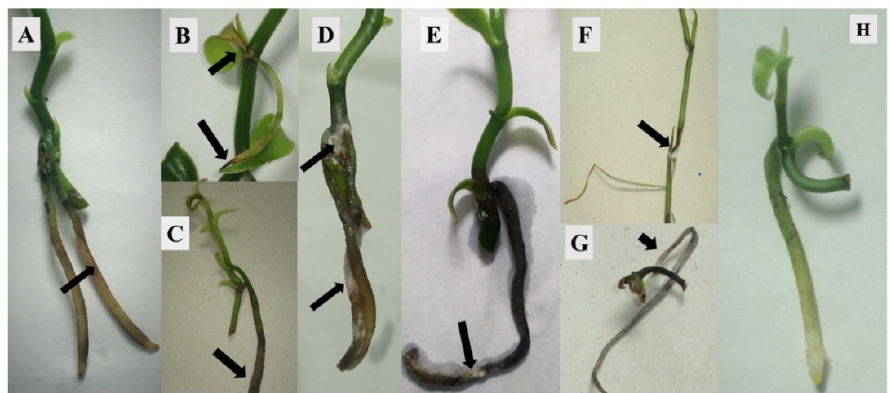
Figure 5. Development of symptoms caused by isolates of Fusarium oxysporum f. sp. vanillae in vanilla accessions. ( A ) Root browning in contact with the culture medium, V. planifolia NSF092; ( B ) aerial root with necrotic tip and wilted leaf, V. planifolia NSF021; ( C ) development of mycelium and wet root rot in contact with the culture medium of the F1 hybrid (NSF059 × NSF07); ( D ) wet root rot in contact with the culture medium, V. planifolia NSF092; ( E ) root dry rot in contact with the culture medium, V. planifolia NSF092; ( F ) stem strangulation, V. odorata (NSF023); ( G ) root strangulation in contact with the culture medium, V. planifolia NSF092; ( H ) control plant not inoculated with the pathogen. Symptoms and signs of the disease are shown with black arrows.